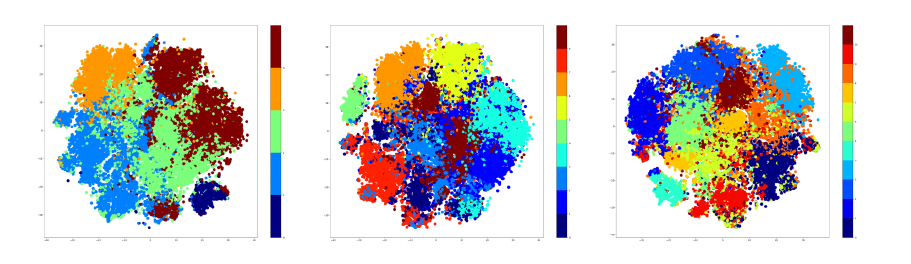
Figure 7. t-SNE plotting for K-Means applied on NTU-RGB+D dataset using 5, 9, and 15 clusters.